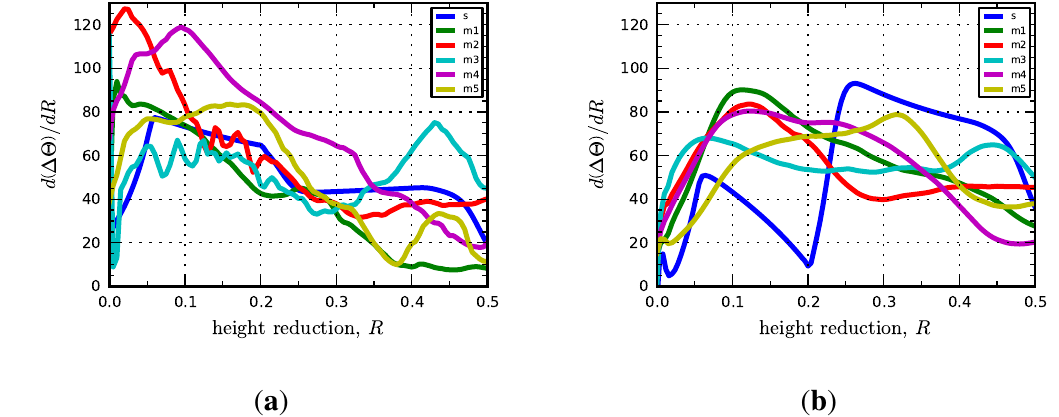
Lattice reorientation rate plotted as a function of height reduction for the ( a ) copper phase in the KS interface; and ( b ) niobium phase in the KS interface. In the legend, “s” refers to the periodic bicrystal simulations and the “m1, m2, ...” refer to the different realizations of the multicrystal